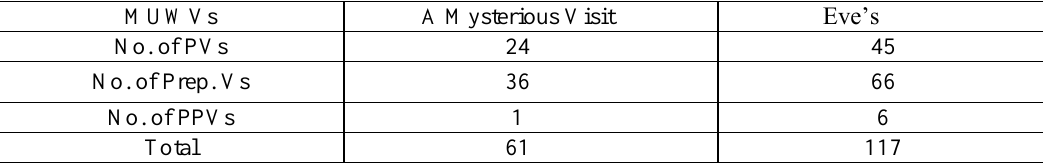
Table – 1: Comparison on MUWVs numbers between MV and ED